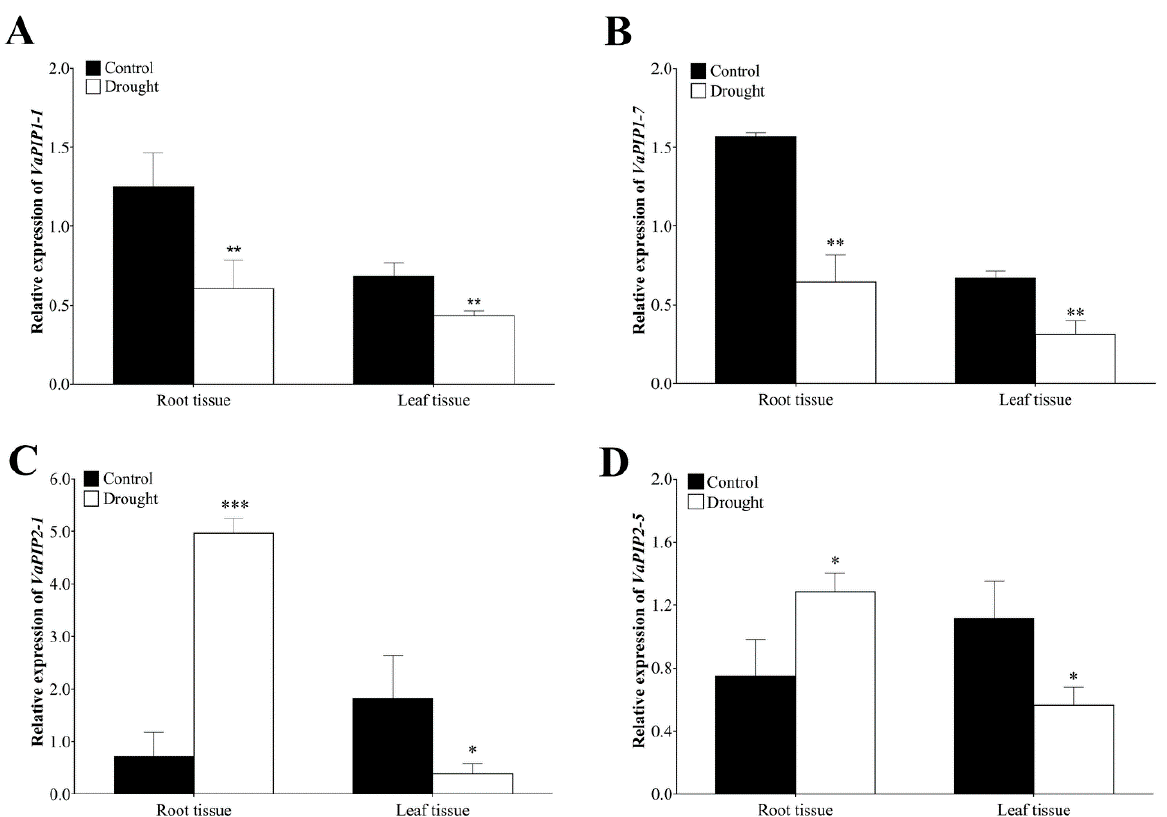
Figure 7. Expression analysis of VaAQPs genes under drought stress and control plants of the adzuki bean. The relative expression levels of ( A ) VaPIP1-1 , ( B ) VaPIP1-7 , ( C ) VaPIP2-1 , and ( D ) VaPIP2-5 in root and leaf tissue. Data are means ± SD of n = 4 biological replicates. Error bars represent standard deviation. Means were analyzed for significant differences using the Student’s t -test. Asterisks (*) indicate differences at 5% level of significance (*** p < 0.001, ** p < 0.01, * p < 0.05).